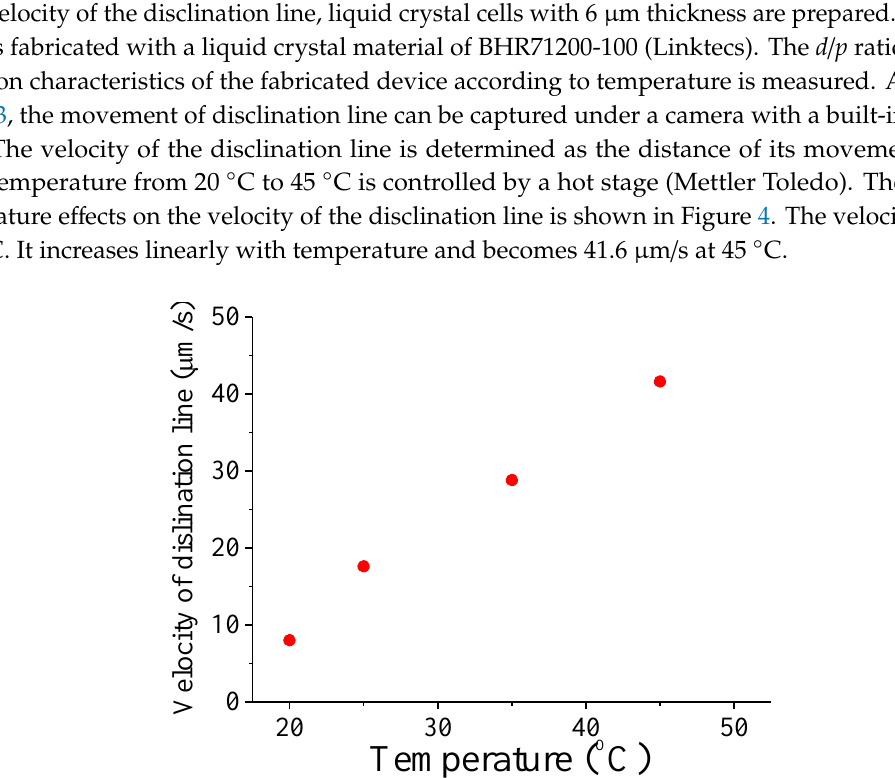
Figure 4. Measured velocity of the disclination line with respect to the temperature.